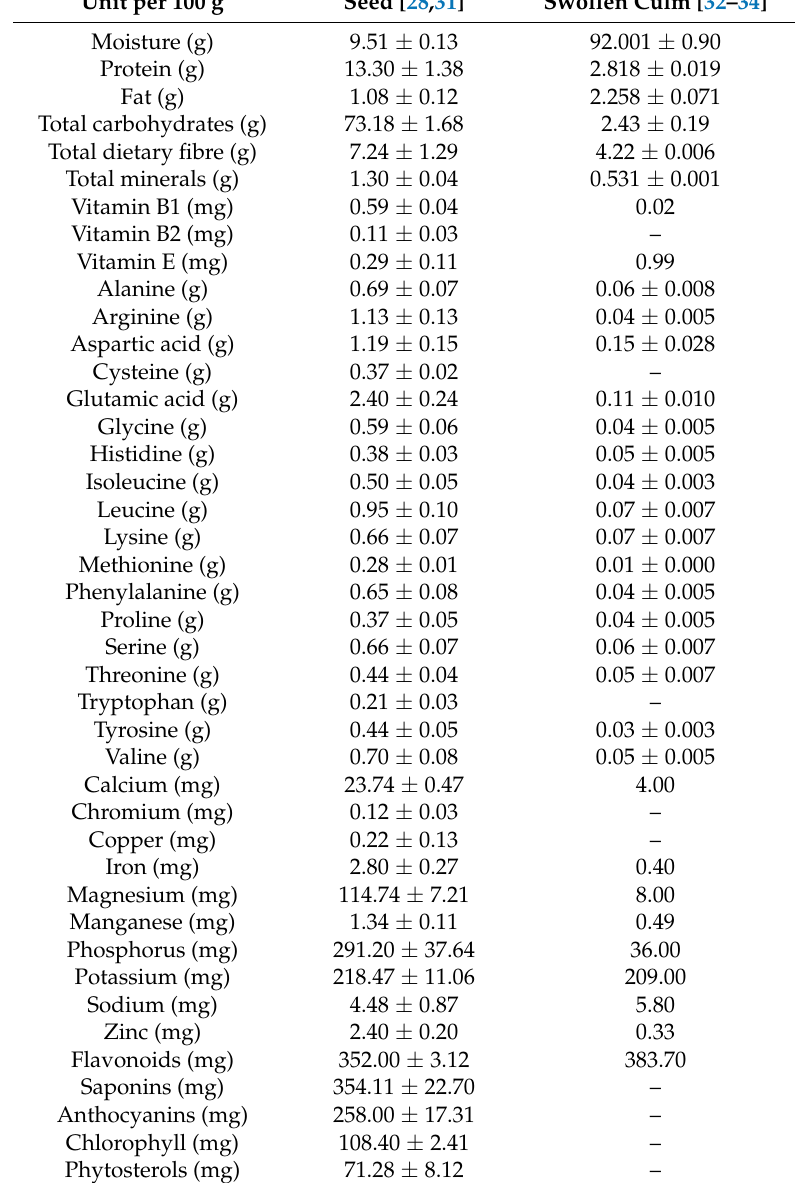
Table 1. Nutrients and bioactive compounds of the seed and swollen culm of Z. latifolia